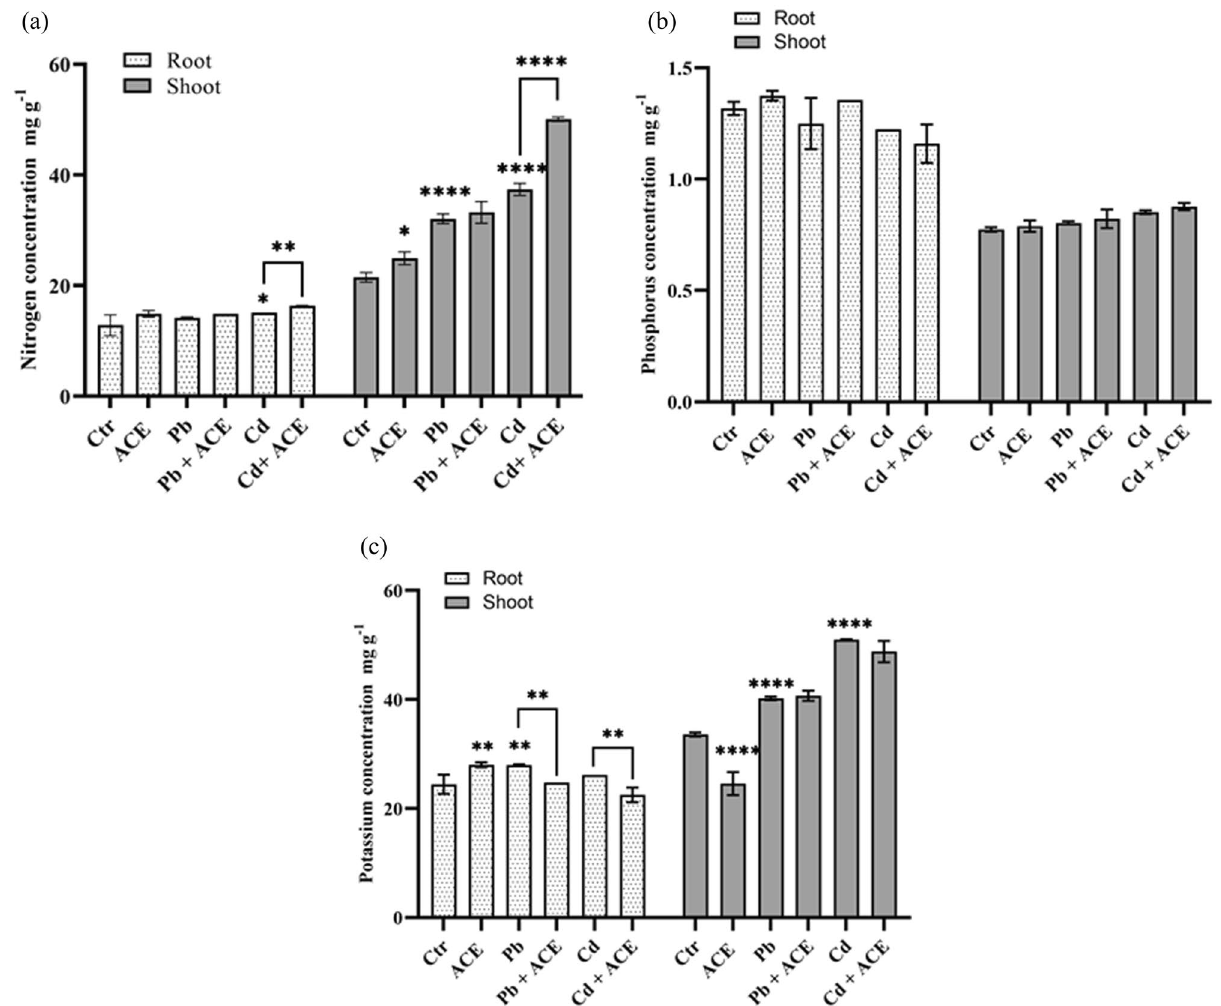
Figure 6. Effect of ACE on macro element N ( a ), P ( b ), K ( c ) uptake and translocation under Pb and Cd stress. (Figure generated by GraphPad prism 9 software, while “*” indicates statistical significance ( P < 0.05); “**” indicates statistical significance ( P < 0.01); “***” indicates statistical significance ( P < 0.001); “****” indicates statistical significance ( P =